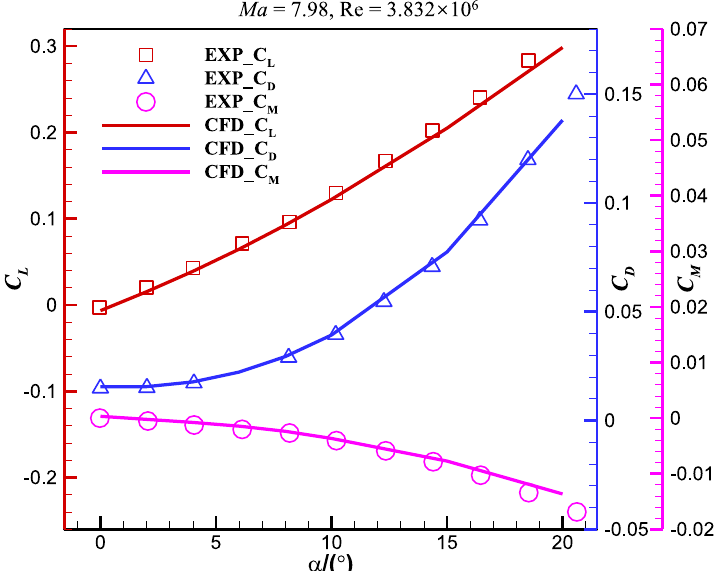
Fig. 6 Comparison of computed force coefficients with experimental data for the FDL‑5A